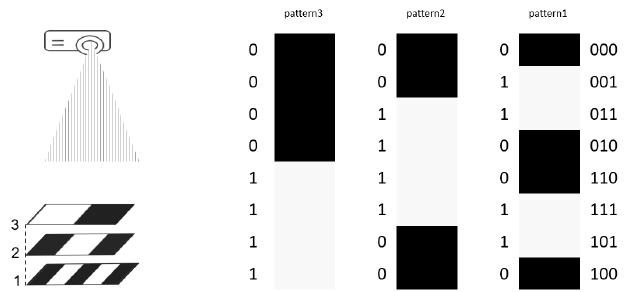
Figure 3. Gray Code patterns ( N =